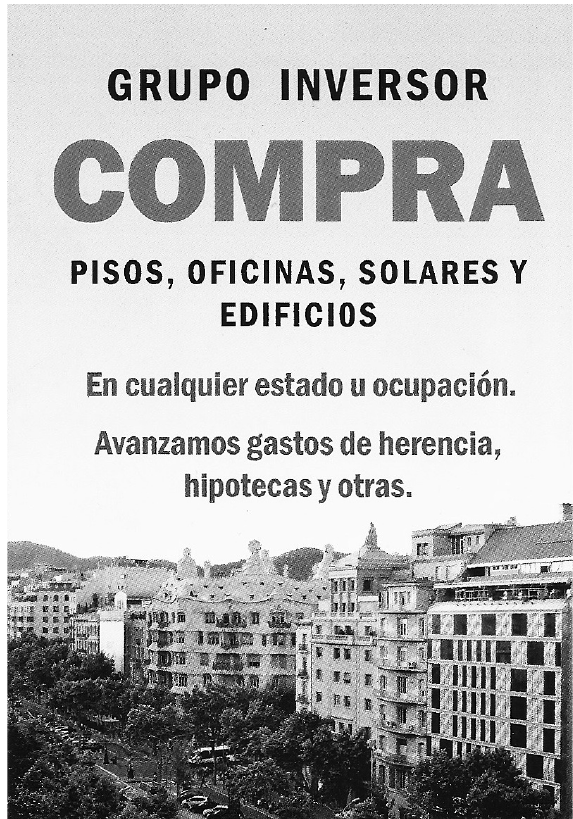
Figure 4. Investor announcement for a real-state pur- chase; they are commonly found in the accesses to res- idential buildings in downtown Barcelona. Source: un- known, collected in a residential building of Sant Antoni